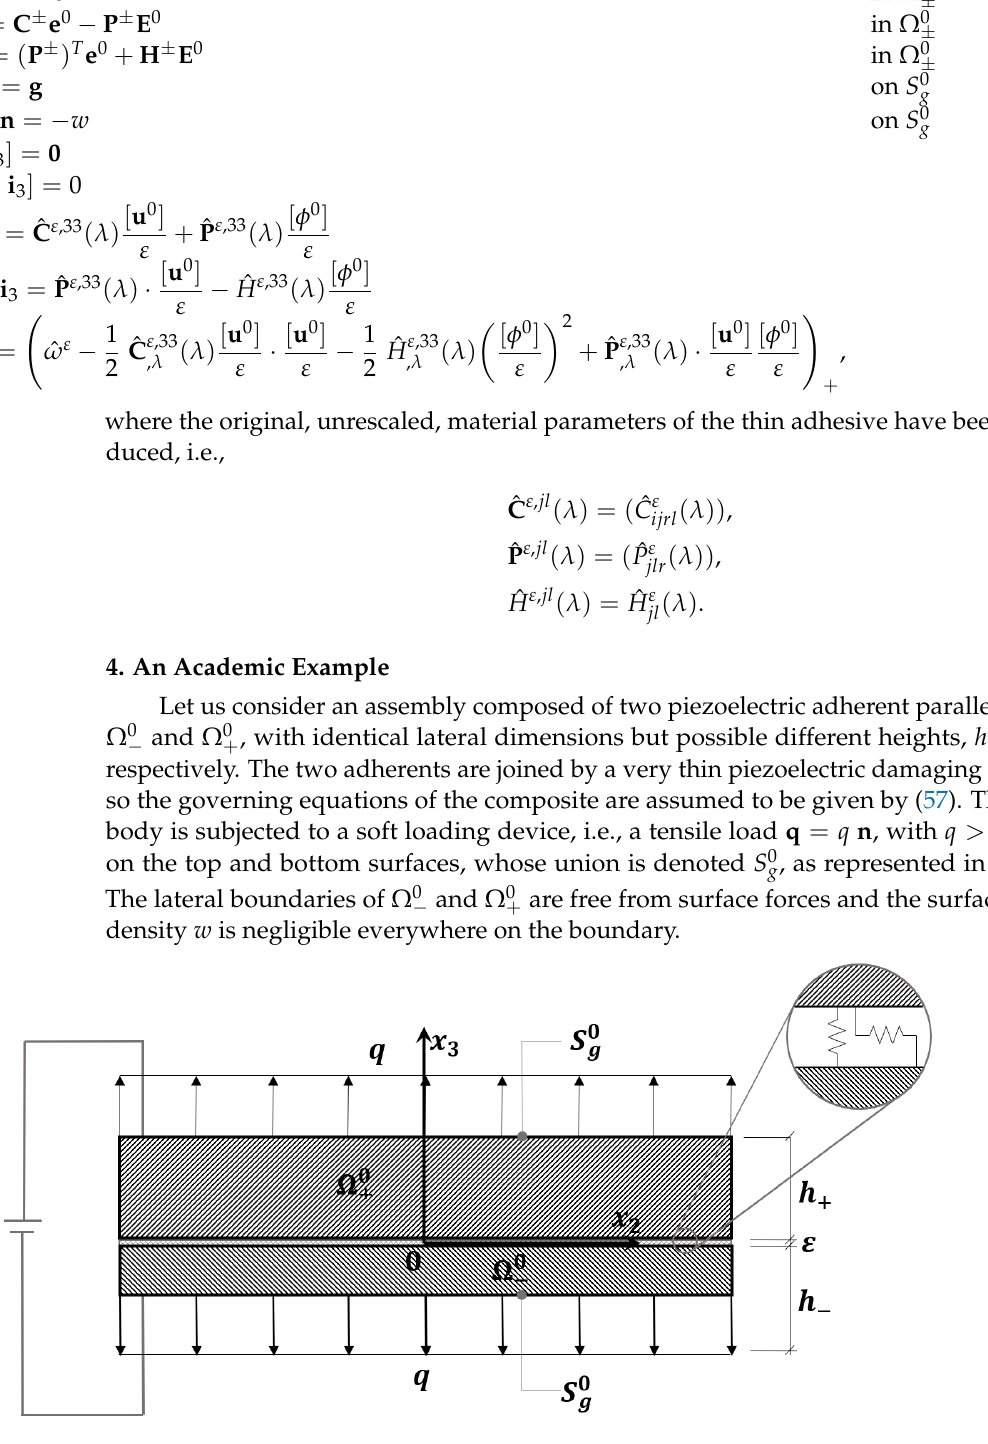
Figure 2. A piezoelectric three-layered composite body subject to soft loading. The intermediate thin layer is made of a damaging